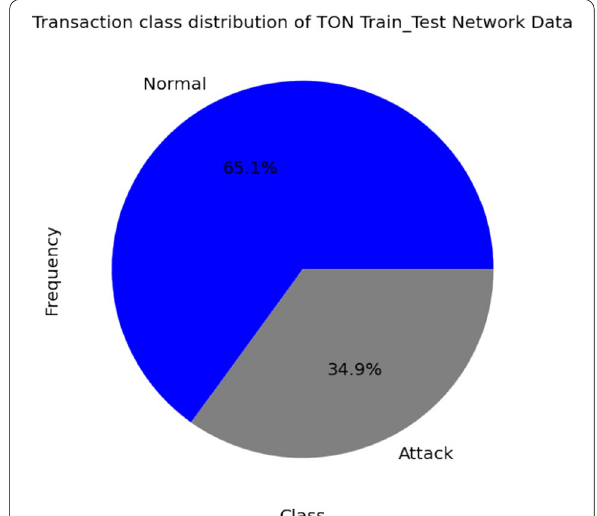
Fig. 5 Class distribution in TON_Train_Test Network data